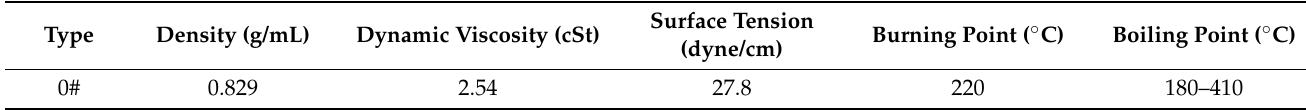
Table 2. Part of the physical properties of diesel.